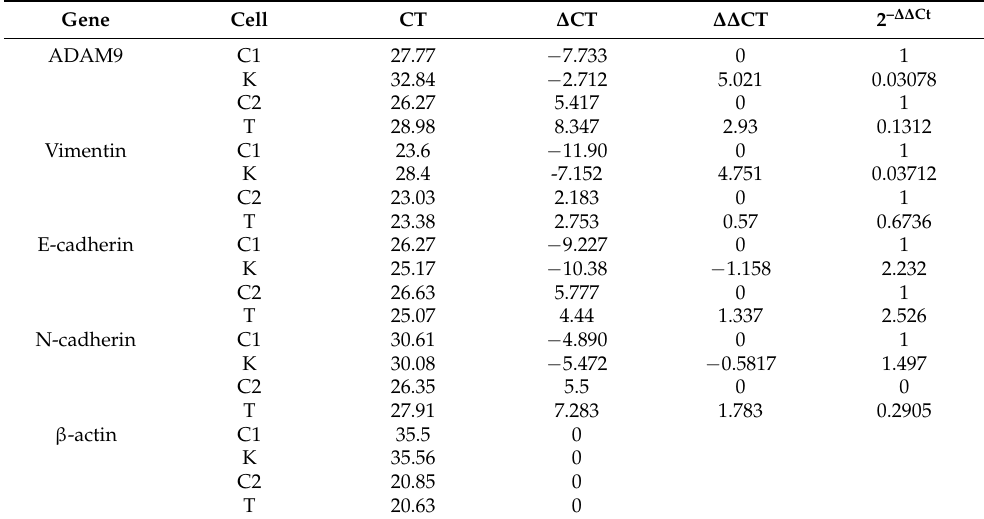
Table 2. Row and calculated data using the double delta method (average).